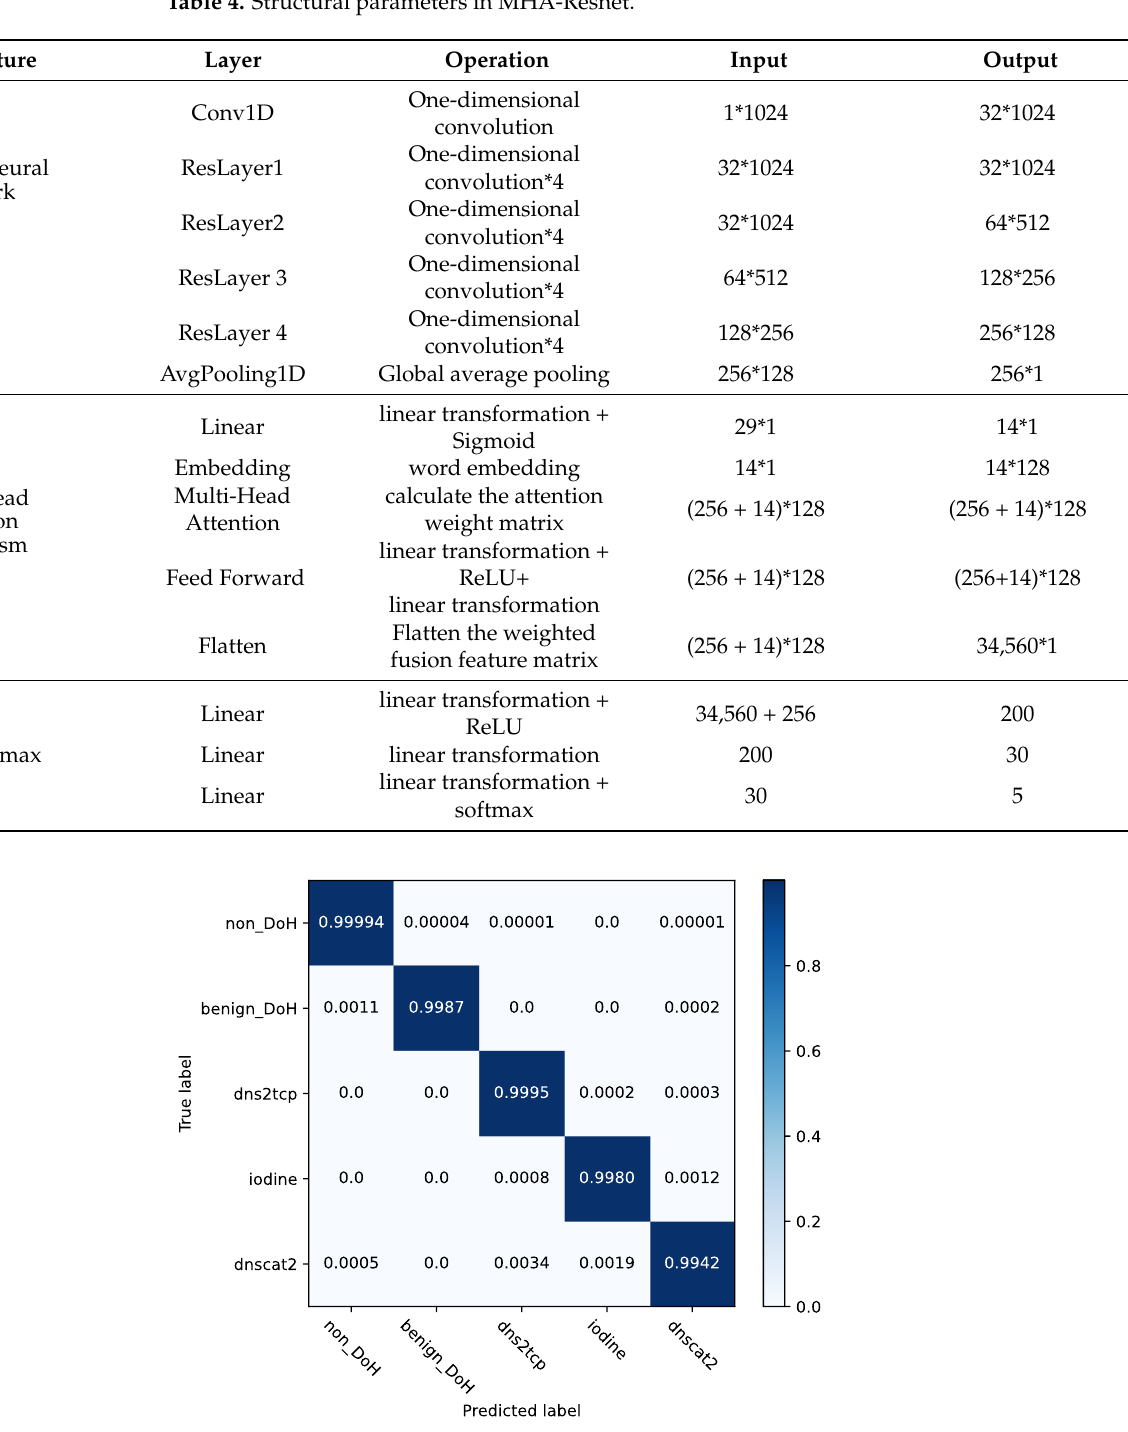
Figure 8. Normalized confusion